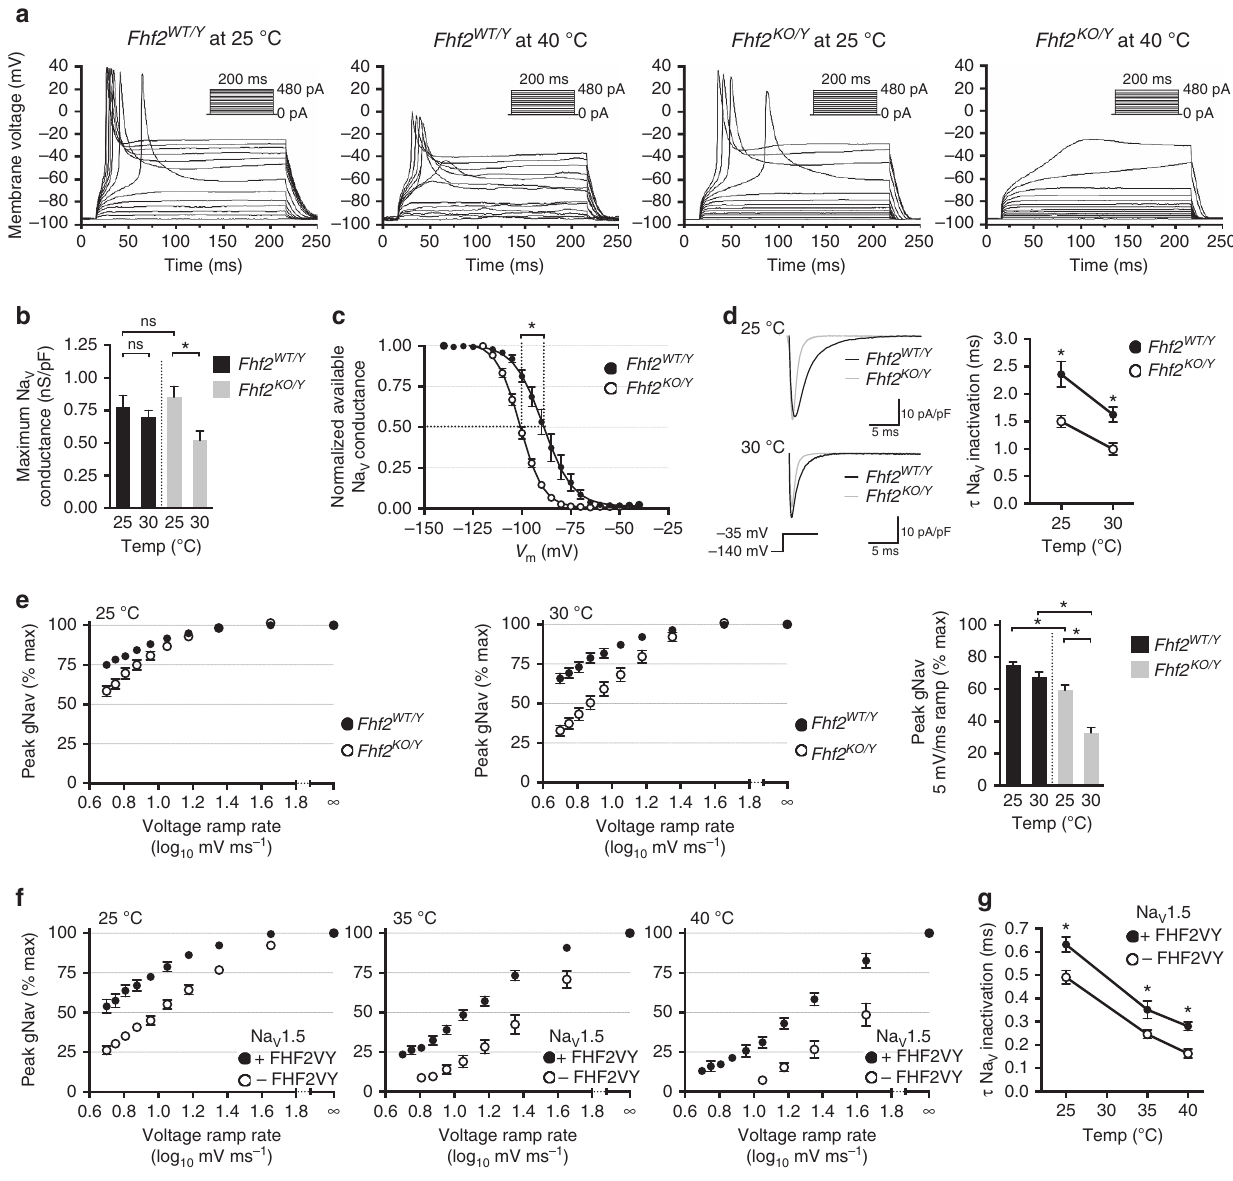
Figure 3 | Temperature-dependent excitation failure and altered sodium channel gating in the absence of FHF2. ( a ) Ventricular cardiomyocyte excitability. Superimposed voltage traces of representative patched Fhf2 WT/Y and Fhf2 KO/Y cardiomyocytes injected with depolarizing current (0–480pA in 40pA steps) at 25 (cid:2) C and in the same cells after raising temperature to 40 (cid:2) C. All tested Fhf2 KO/Y cells were inexcitable at 40 (cid:2) C. ( b ) Cardiomyocyte Na V peak conductance (gNa V -peak). gNa V -peak following (cid:2) 120mV to (cid:2) 35mV depolarization step was measured for Fhf2 WT/Y and Fhf2 KO/Y cells at 25 (cid:2) C and 30 (cid:2) C. ( c ) Cardiomyocyte Na V steady-state inactivation. Available gNa V at 25 (cid:2) C after 60ms conditioning at (cid:2) 140 to (cid:2) 40mV is expressed as fraction maximal gNa V . Vertical dashed lines indicate V 1/2 inactivation in Fhf2 WT/Y and Fhf2 KO/Y cells. ( d ) Cardiomyocyte Na V open-state inactivation rate. Superimposed representative traces (left) from Fhf2 WT/Y (black line) and Fhf2 KO/Y (grey line) cardiomyocytes at 25 (cid:2) C (top) and 30 (cid:2) C (bottom) following depolarization to (cid:2) 35mV. Fast exponential time constant ( t ) for decay of sodium current in response to voltage step to (cid:2) 35mVare plotted for Fhf2 WT/Y and Fhf2 KO/Y cells at 25 and 30 (cid:2) C (right). ( e ) Voltage ramp Na V inactivation in cardiomyocytes. gNa V -peak in response to voltage ramps to (cid:2) 50mV at different rates was expressed as percentage of gNa V -peak elicited by step depolarization ( N ramp rate). Slower ramp rates decrease gNa V –peak through closed-state inactivation, which is sensitized by both elevated temperature and Fhf2 mutation (histogram). See Supplementary Fig. 2 for representative conductance traces. ( f ) Voltage ramp Na V 1.5 inactivation with and without FHF2VY. HEK cells transfected with Na V 1.5 ± FHF2VY subjected to voltage ramps to (cid:2) 30mV at different rates at 25, 35 and 40 (cid:2) C. Na V 1.5 closed-state inactivation is increased by slowed voltage ramp, temperature elevation and the absence of FHF2VY. See Supplementary Fig. 3 for representative conductance traces. ( g ) Na V 1.5 open-state inactivation. Fast t for Na V 1.5 current decay was measured in cells ± FHF2VYat 25, 35 and 40 (cid:2) C. Elevated temperature and absence of FHF2VYeach accelerate Na V 1.5 open-state inactivation. Data represent mean ± s.e.m. *significant P values (all P values in Supplementary Tables 4 and 5); ns, not significant; Student’s t